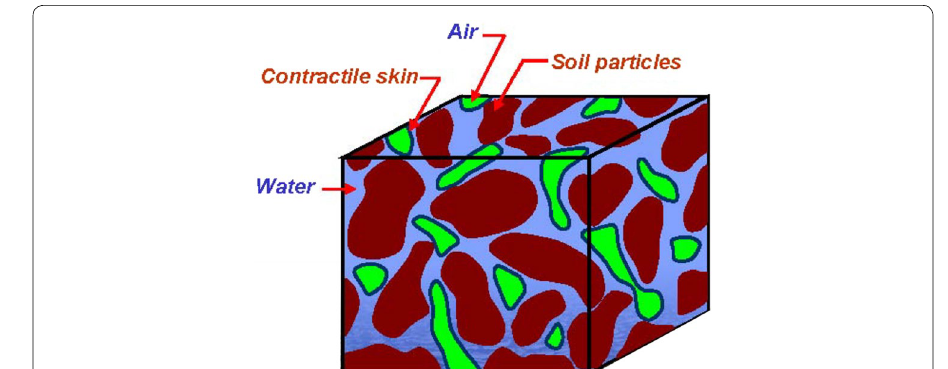
Fig. 2 Unsaturated soil phases (modified from Fredlund and Rahardjo